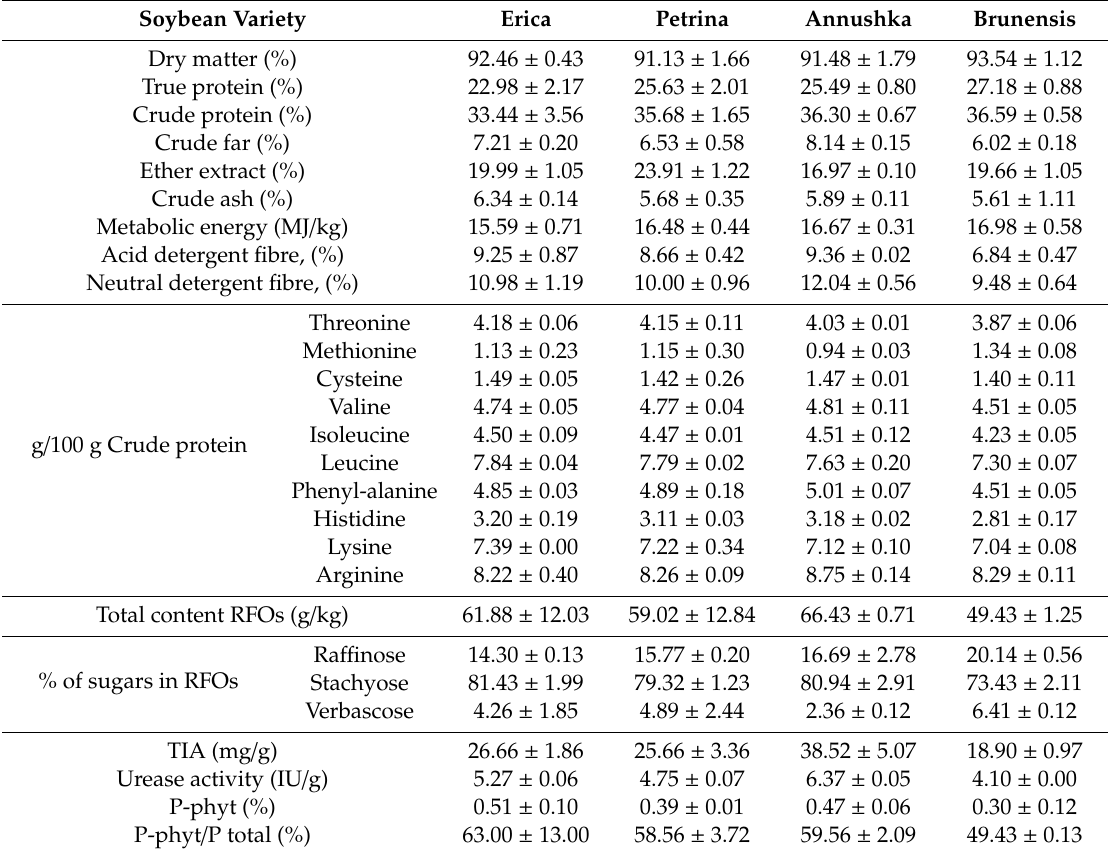
Table 2. The average chemical composition of di ff erent soybean seeds varieties (% in dry matter (DM)) with a low level (about 37%) of protein in